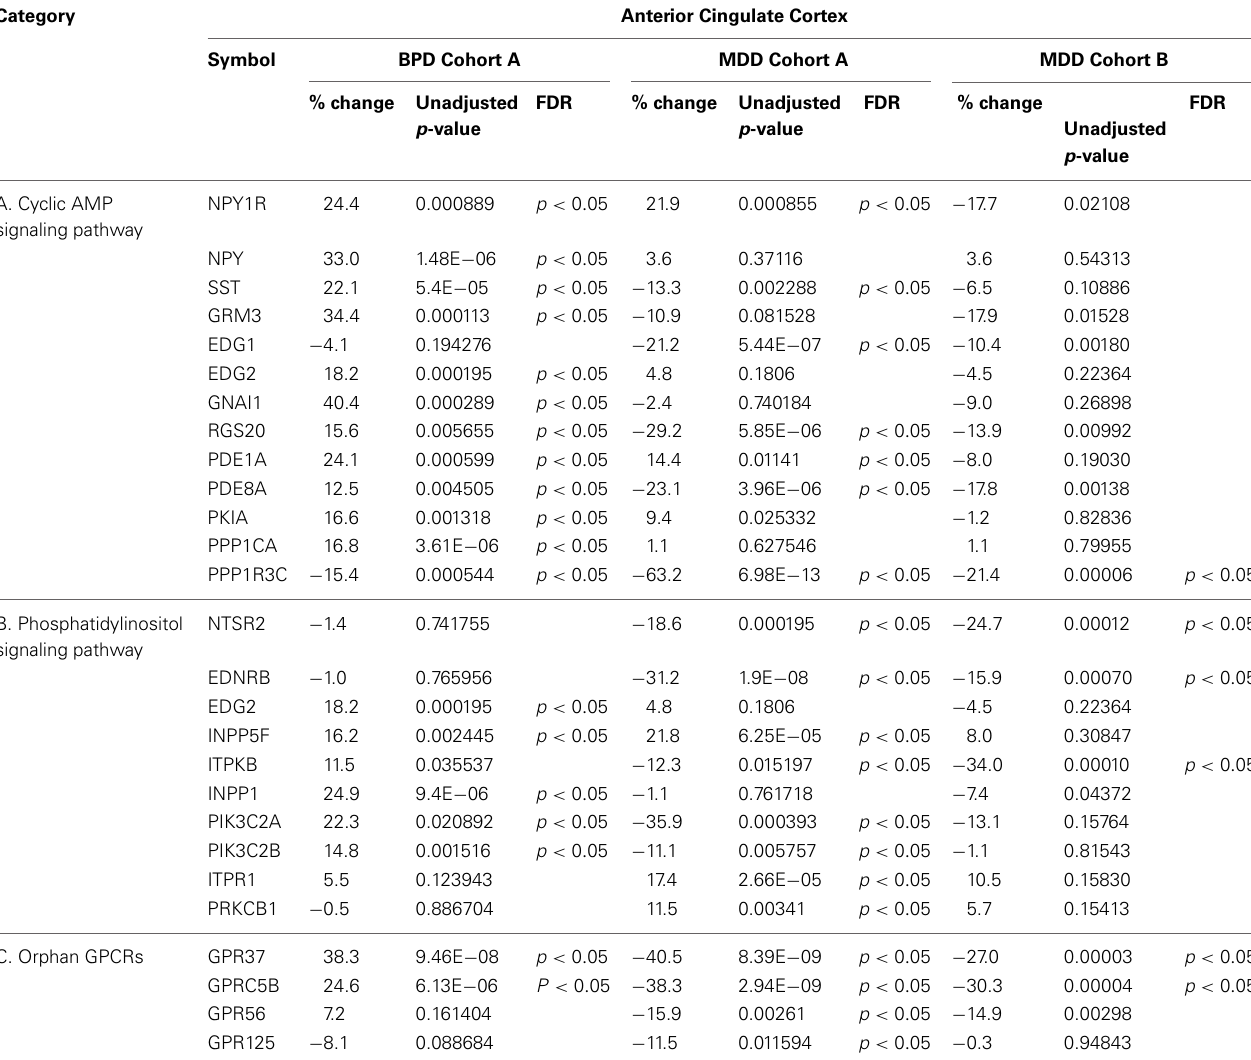
Table 2 | GPLS genes significantly dysregulated in anterior cingulate cortex by